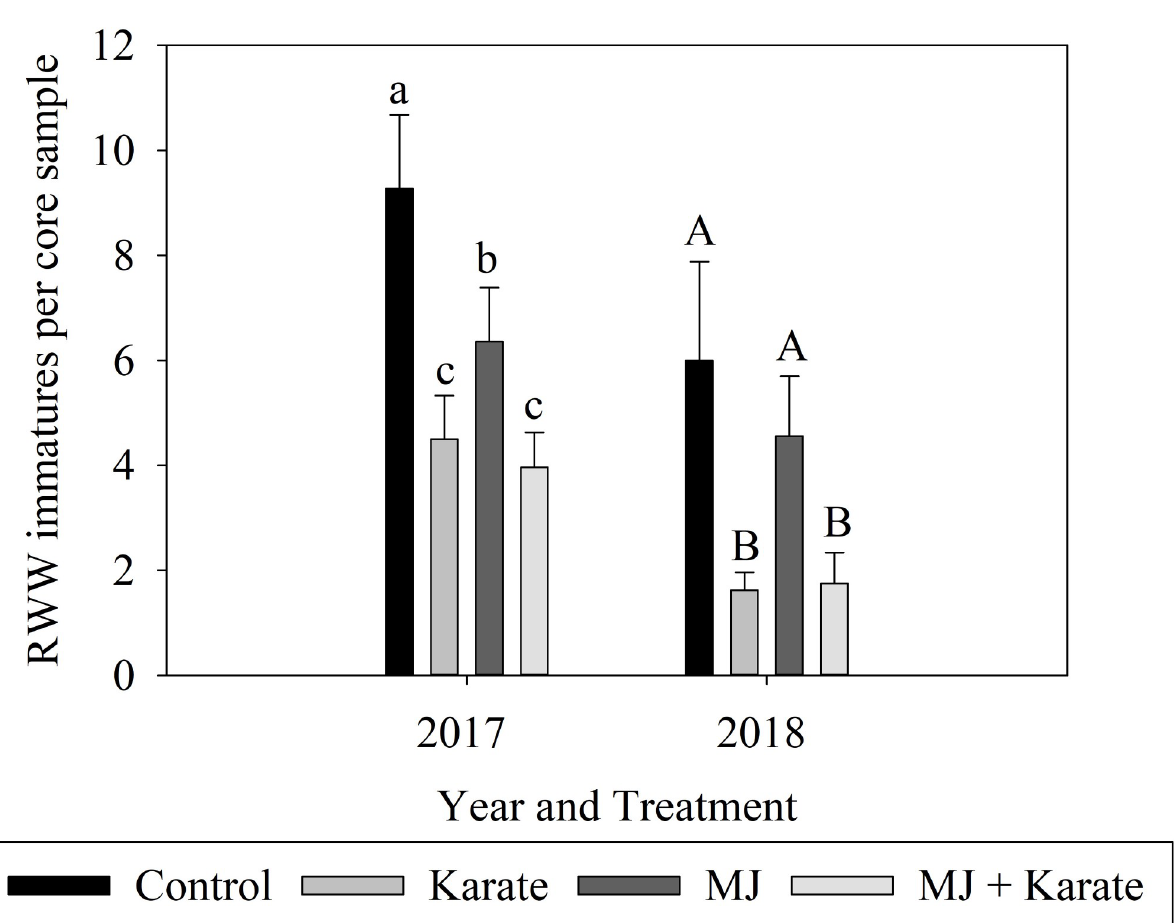
Fig 2. Effects of factorial combinations of methyl jasmonate seed treatment (MJ) and insecticide application (Karate) on densities of RWW larvae (immature RWW per core sample ± SE) associated with roots of rice plants in field plots exposed to natural infestations of RWW in 2017 and 2018. Plots were seeded with untreated seed (Control) or with MJ-treated seeds (MJ), sprayed four times with a pyrethroid insecticide after flooding (Karate), or seeded with MJ-treated seeds and sprayed with insecticide (MJ + Karate). Analyses in 2017 used pooled data from five core- sampling dates. Data from one core sampling date in 2018 are presented. Bars accompanied by different letters represent means that differed significantly by Tukey’s HSD test at α < 0.05.